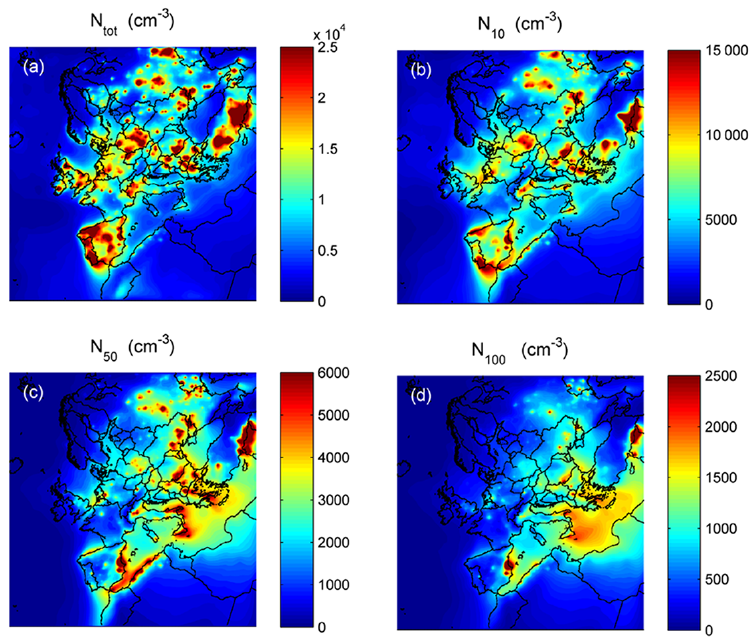
Figure 2. Ground-level average number concentrations (cm − 3 ) predicted by the base case simulation during 5 June–8 July 2012 for (a) all particles ( N tot ) and particles above (b) 10nm ( N 10 ), (c) 50nm ( N 50 ), and (d) 100nm ( N 100 ). Different color scales are